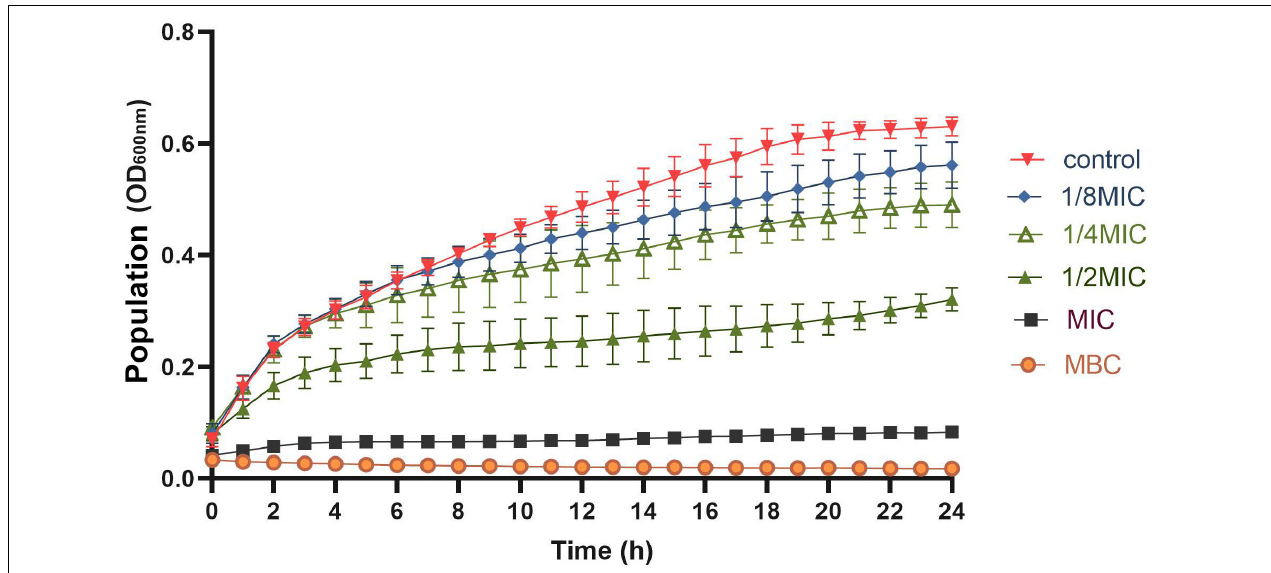
FIGURE 2 | Growth curve of OEO against S. aureus in LB broth at 37 ◦ C; OEO concentrations includes 0 (control), 1/8MIC (0.015625 mg/mL), 1/4MIC (0.03125 mg/mL), 1/2MIC (0.0625 mg/mL), MIC (0.125 mg/mL), and MBC (0.25